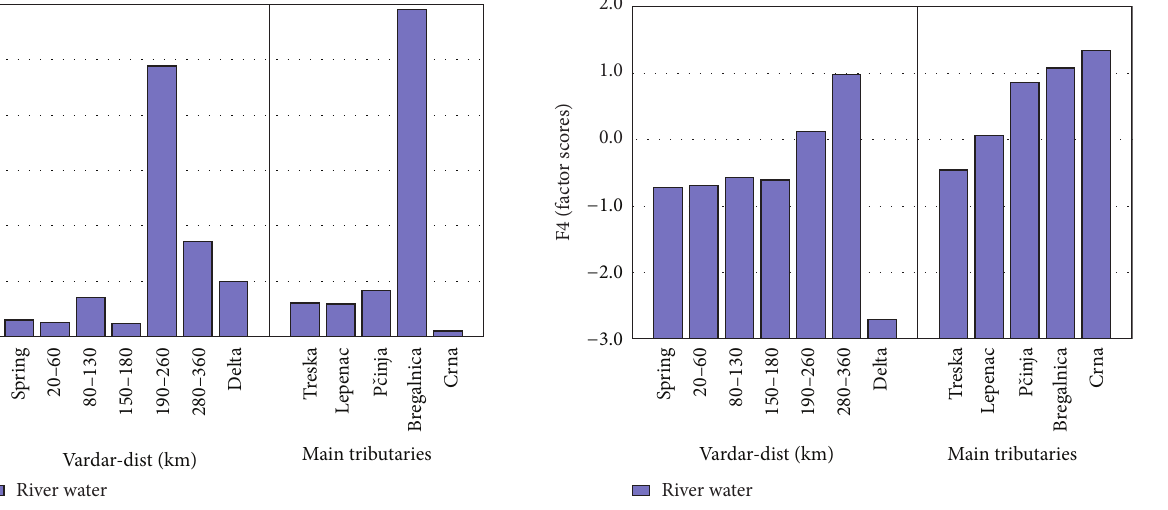
Figure 9: Concentration of Cd found in river Vardar and main tributaries.